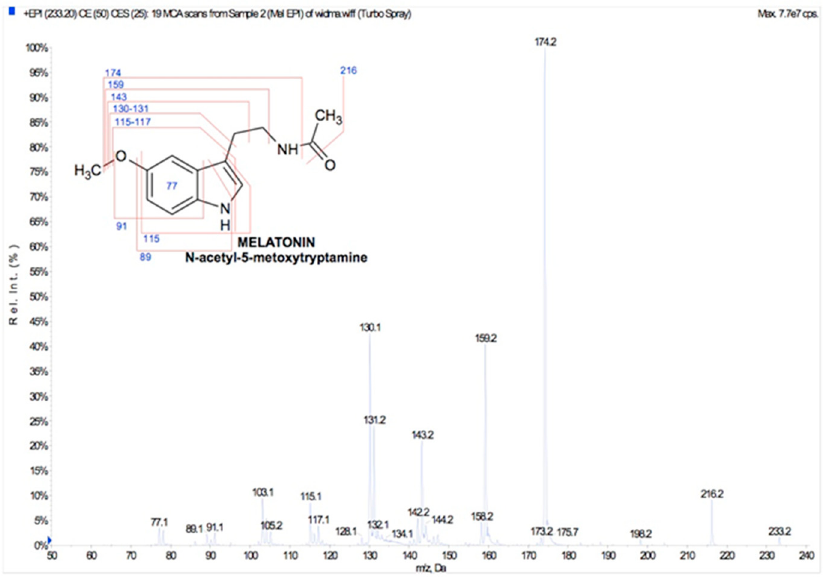
Figure 1. Chemical structure and mass spectrum of melatonin fragmentation pattern.